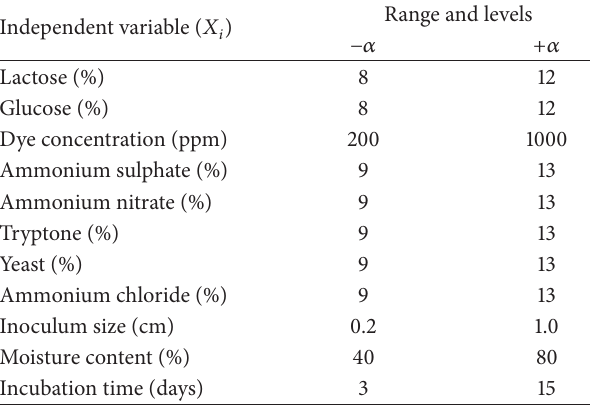
Figure 1: Complete dye decolourization by M. cladophyllus UMAS MS8resultingintheformationofhalo(arrow)onagarplatemedium containing